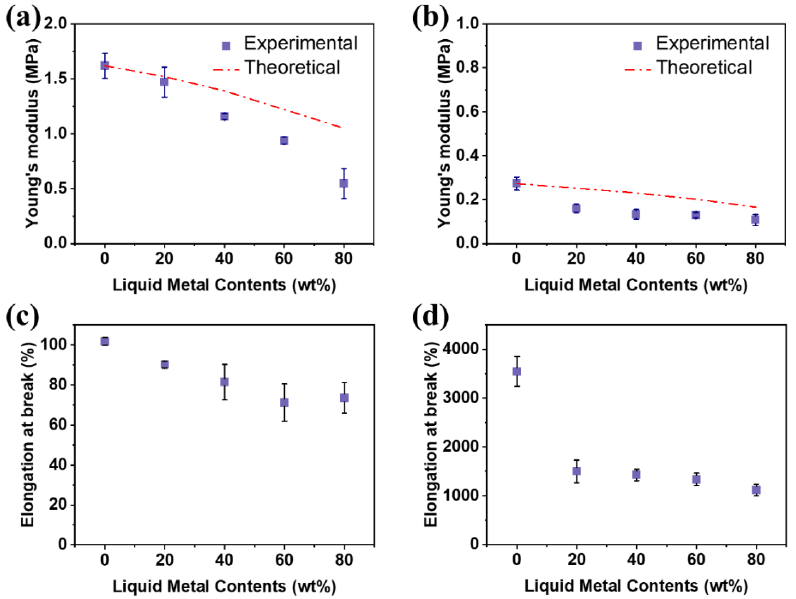
Figure 2. Mechanical properties of the liquid metal elastomer films made of Sylgard 184 ( a , c ) and ExSil 100 ( b , d ). ( a , b ) Young’s modulus of the liquid metal elastomer films as a function of the contents of liquid metal fillers. ( c , d ) Plot of elongation at break of the liquid metal elastomer films as a function of the contents of the liquid metal fillers.